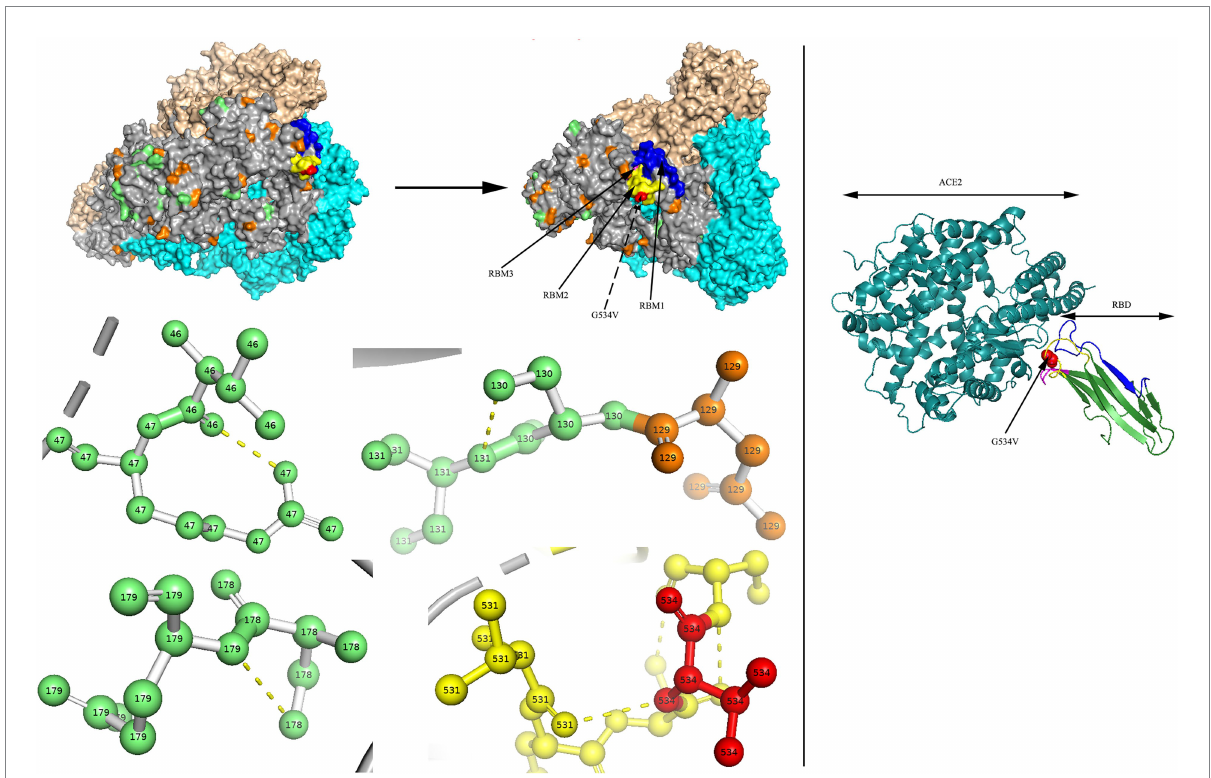
FIGURE 8 N-glycosylation and aa substitution sites of S protein of H45. Homology modeling was using the template of 7KIP. The trimeric structure model is shown as surface and chains A to C, (colored gray, cyan, and wheat, respectively). The N-glycosylation sites and amino acid substitution sites are shown in orange and green, respectively, while residue G534 is colored red. RBM1, RBM2 and RBM3 in the RBD region are shown in blue, yellow and magenta, respectively. The dashed yellow line indicates polar contact between the residues. The crystal structure of 3KBH is shown on the